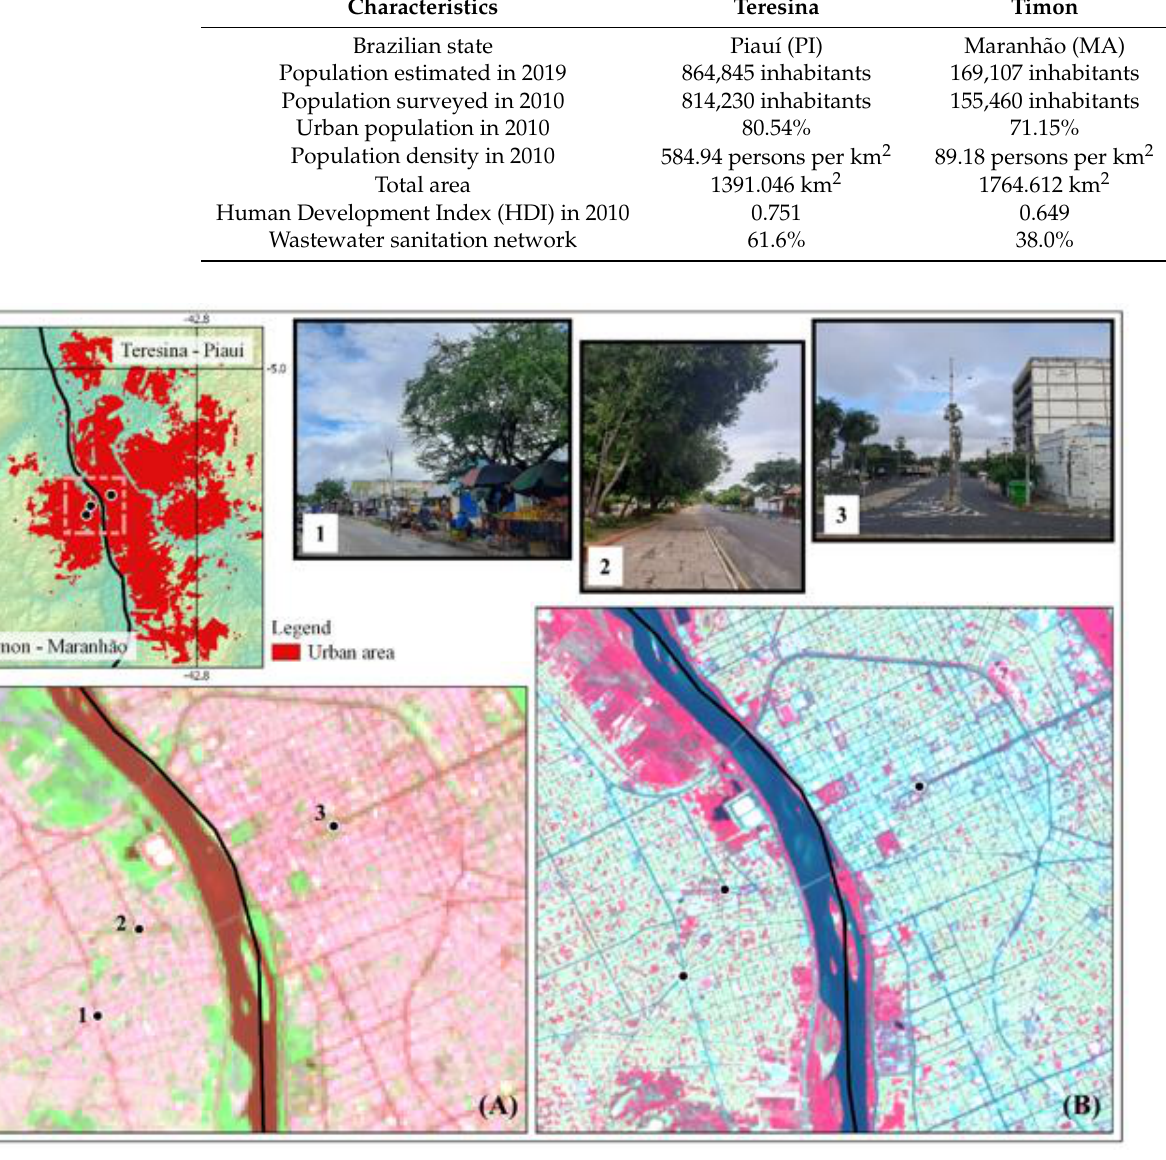
Figure 2. Urban area coverage of Teresina-Timon conurbation (TTC) expansion in 2018 with the location of panoramic field photos; ( A ) Operational Land Imager (OLI) Landsat-8 color composition, bands 6(R)5(G)4(B), acquisition date in 07/12/2019, vegetation appears green and urban area has a magenta hue; ( B ) Multispectral Instrument (MSI) Sentinel-2A color composition, bands 8(R)4(G)3(B), acquisition date in 08/11/2019, vegetation appears red and urban area has a blue hue; (1 and 2) panoramic field photos of Timon; (3) panoramic field photo of Teresina.